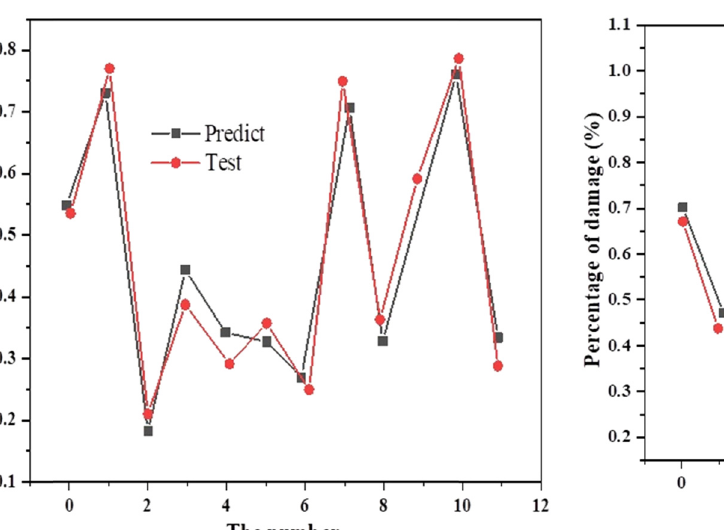
Figure 5: Bridge damage fi tting degree at 350